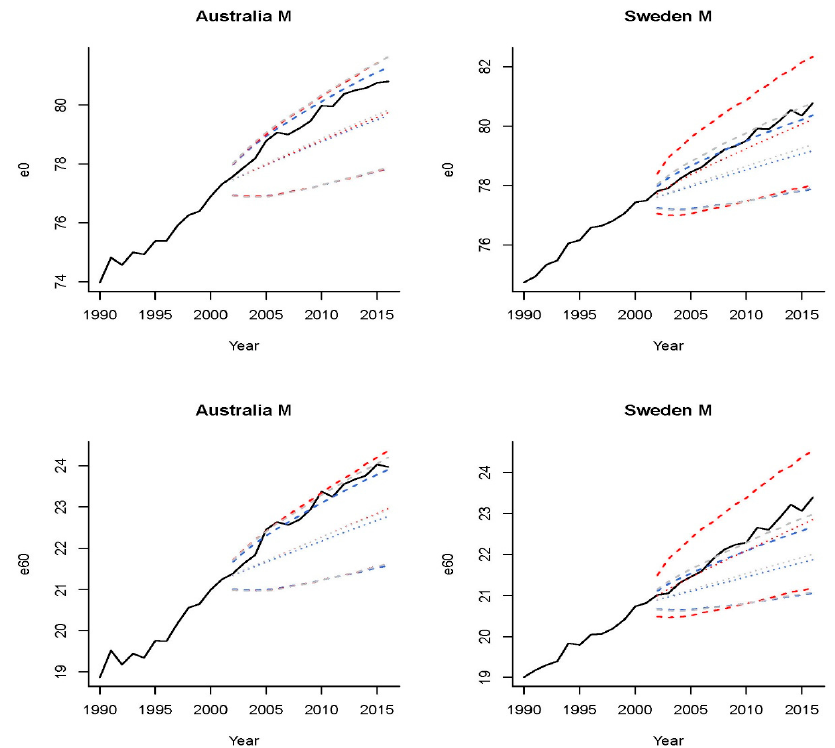
Figure 7. Observed values (solid lines), projected values (dotted lines) and 95% prediction intervals (dashed lines) of life expectancies at birth (top panel) and age 60 (bottom panel), calibrated on years 1950–2001. The blue lines correspond to the projections from the original Lee-Carter model, and the red (grey) lines refer to the projections from the Fourier (cubic) Lee-Carter model.